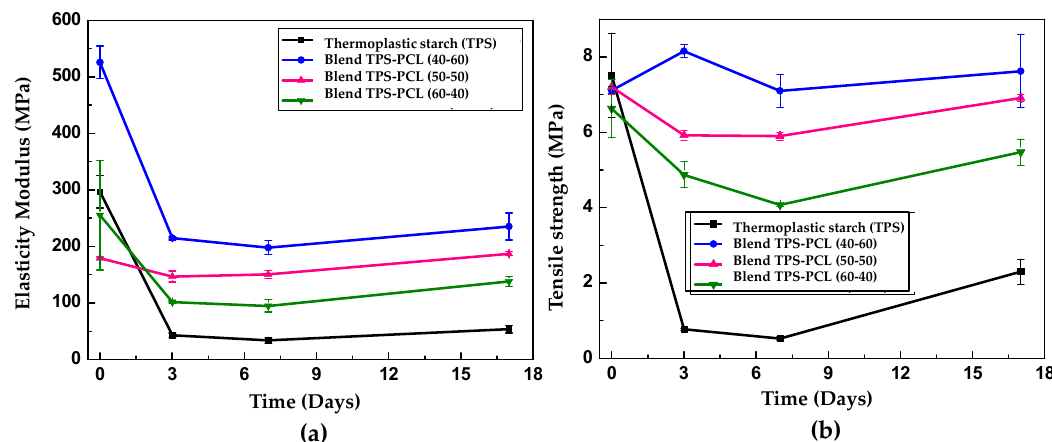
Figure 10. Tensile mechanical properties of TPS/PCL binary blends at 40/60, 50/50, and 60/40 ratios as a function of storage time, at 25 °C, and a relative humidity of 54%. ( a ) Modulus of elasticity and ( b ) maximum strength.